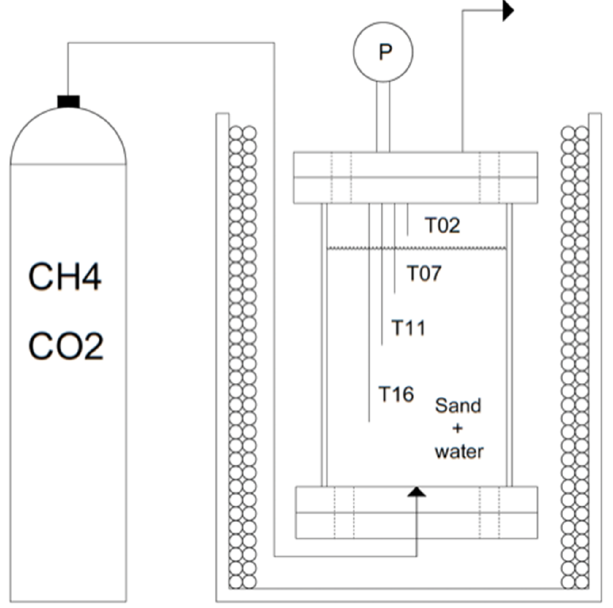
Figure 2. Picture of the lab-scale reactor (at left ), the thermostatic bath in which it is inserted (at right ), and scheme of the whole experimental apparatus ( below ).